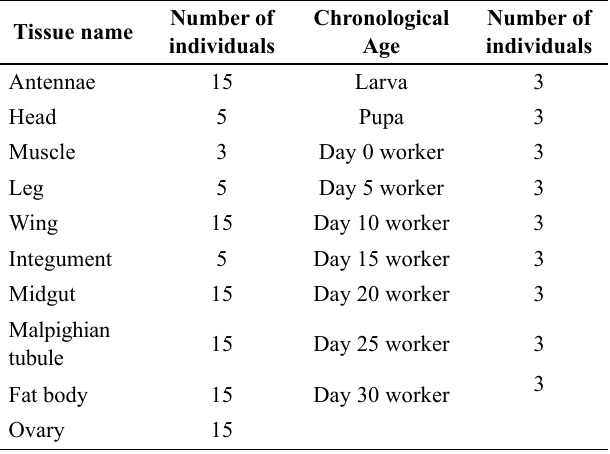
Table 2 . The information of the number of individuals in each biological repetition for different tissues and chronological ages of B. lantschouensis